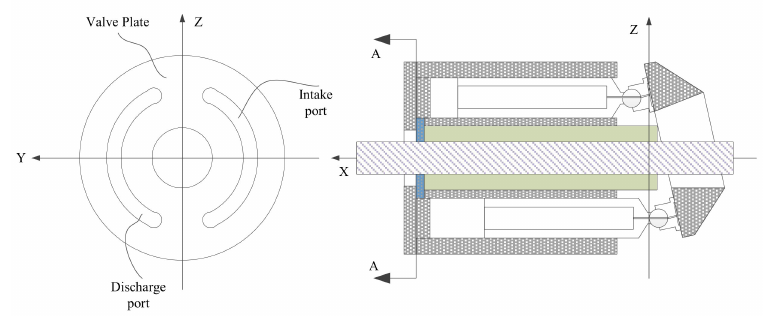
Figure 4. Schematic of the working principle of the plunger pump.